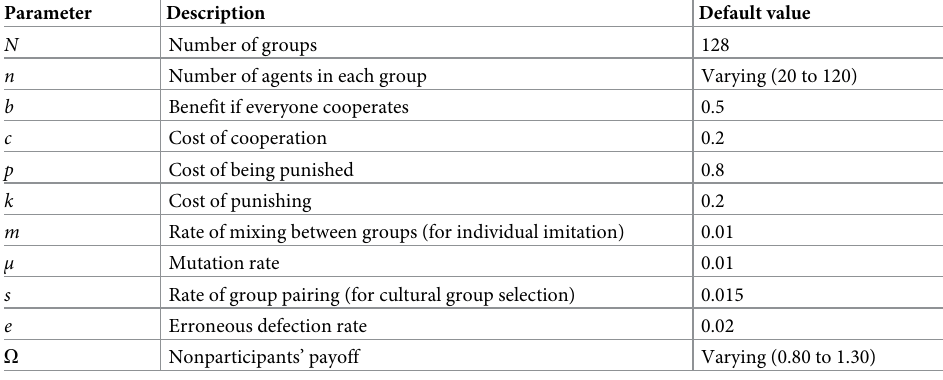
Table 1. Default parameter